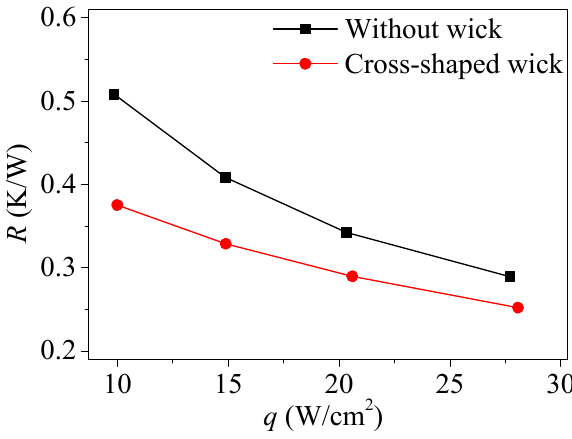
Figure 10. Effect of wick presence on thermal resistance ( H = 15 mm, φ = 50%).